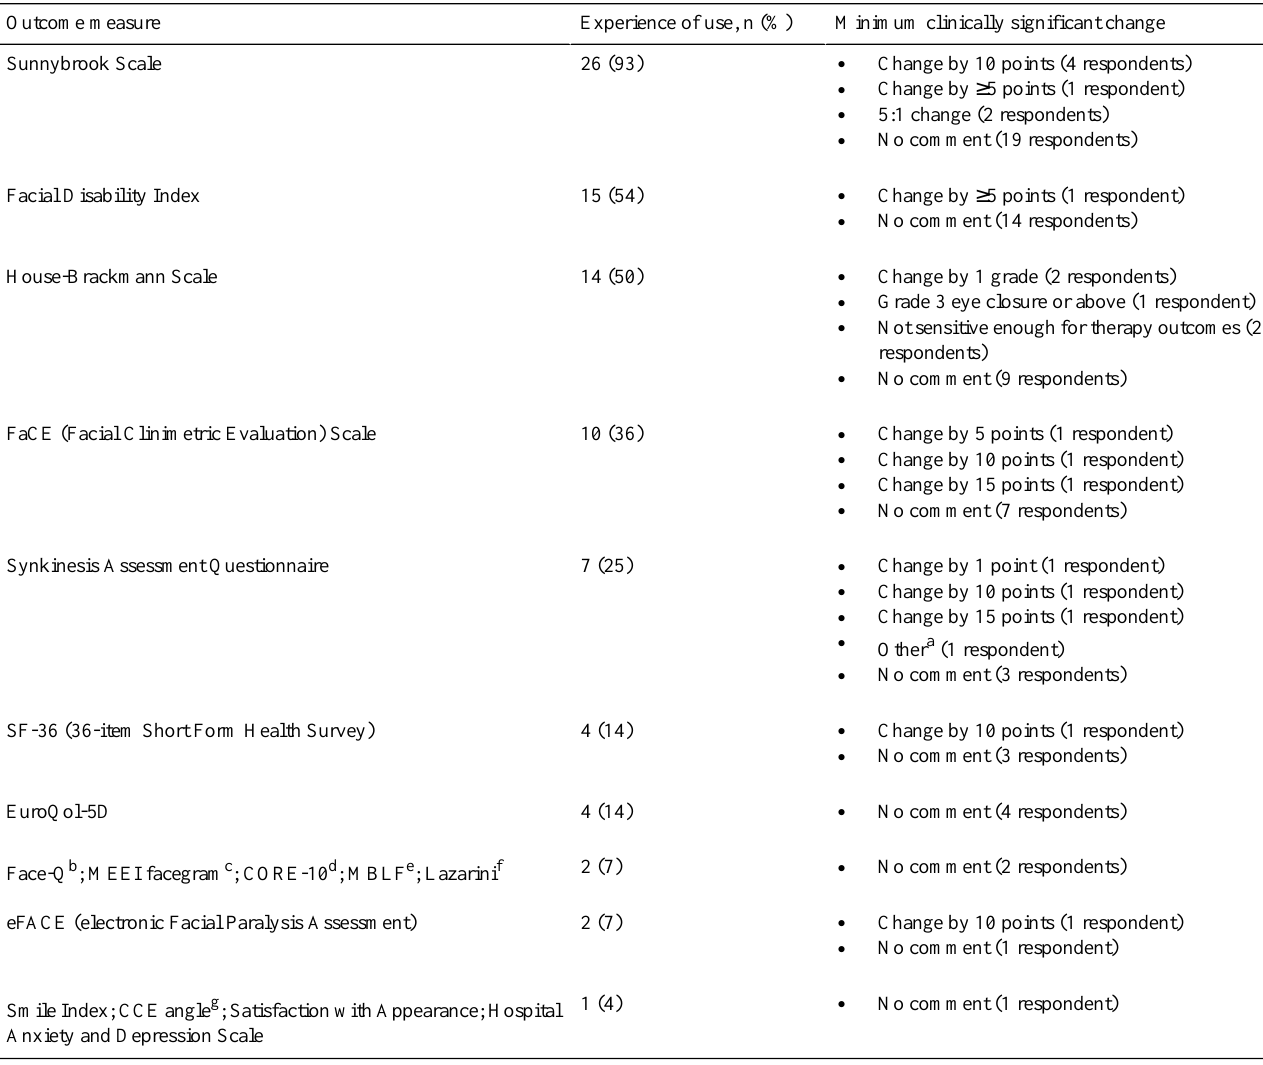
Table 4. Follow-up survey: outcome measures and minimum clinically significant change